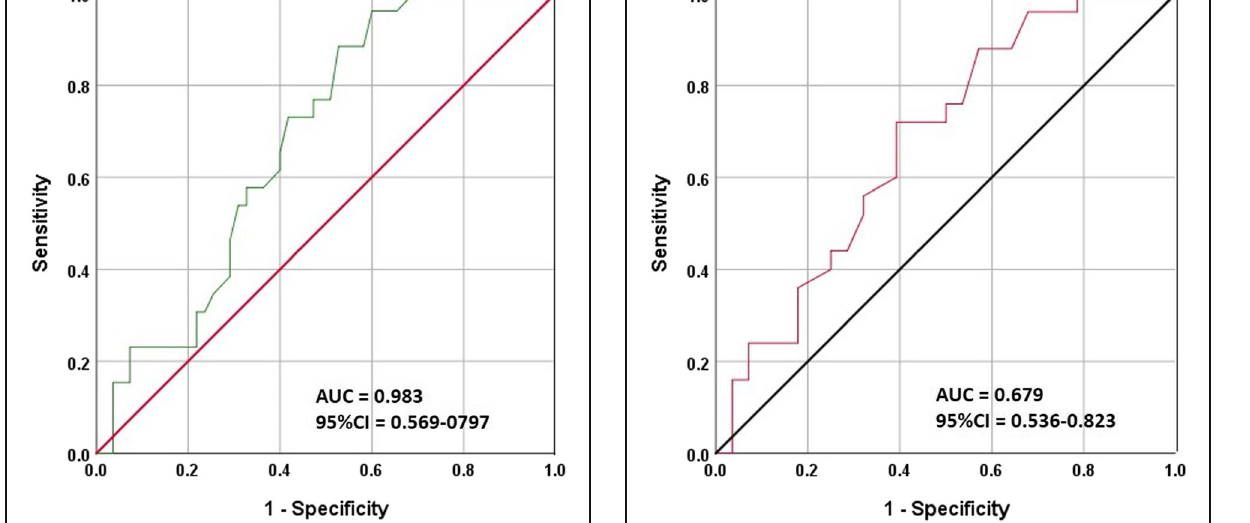
Fig. 1 Receiver operating characteristic curve of MMP-2 in the context of discrimination between epileptic patients and controls. MMP-2, matrix metalloproteinase-2